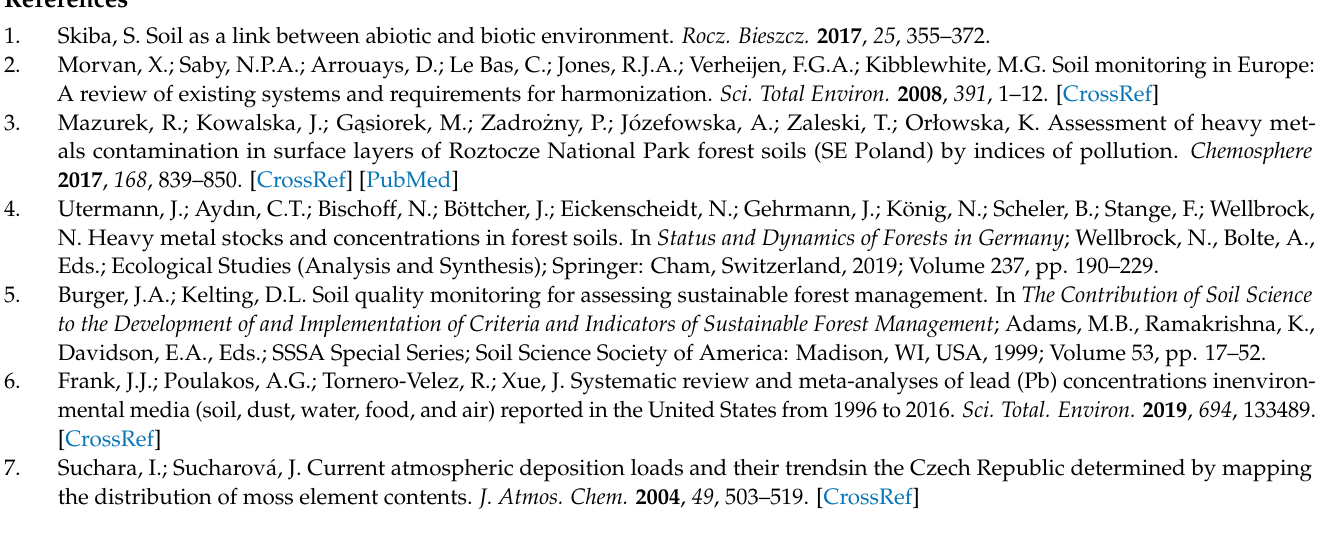
Figure A3. Experimental semivariogram (symbols) and models (line) for total concentration of Pb in the topsoil